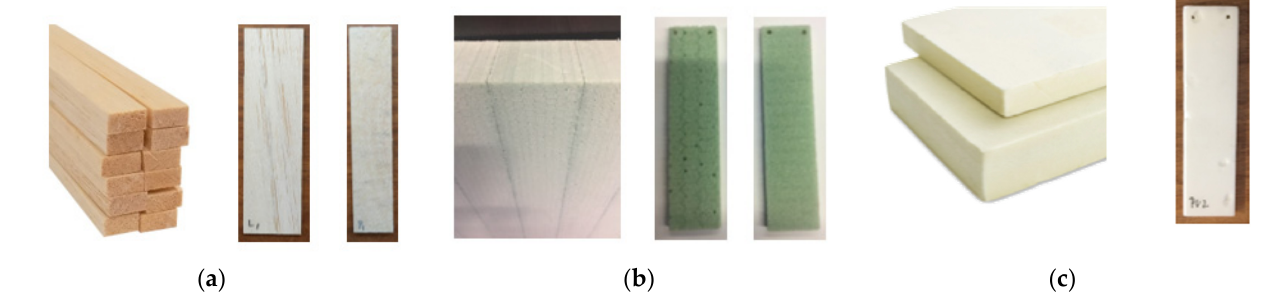
Figure 2. IET test specimens: ( a ) BAL sample; ( b ) PET sample; ( c ) PUR sample.